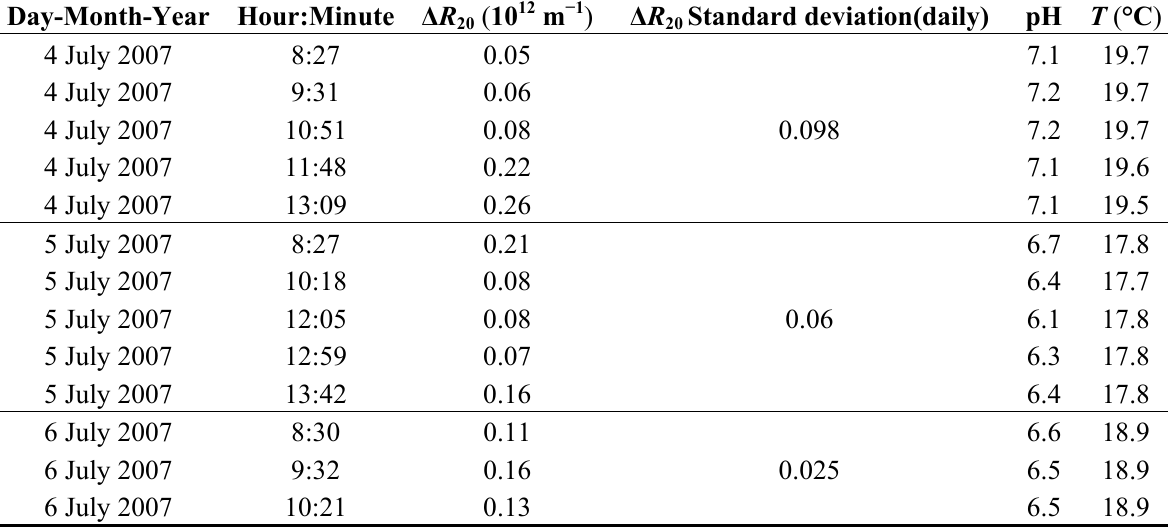
, temperature and pH of MBR activated sludge. 20